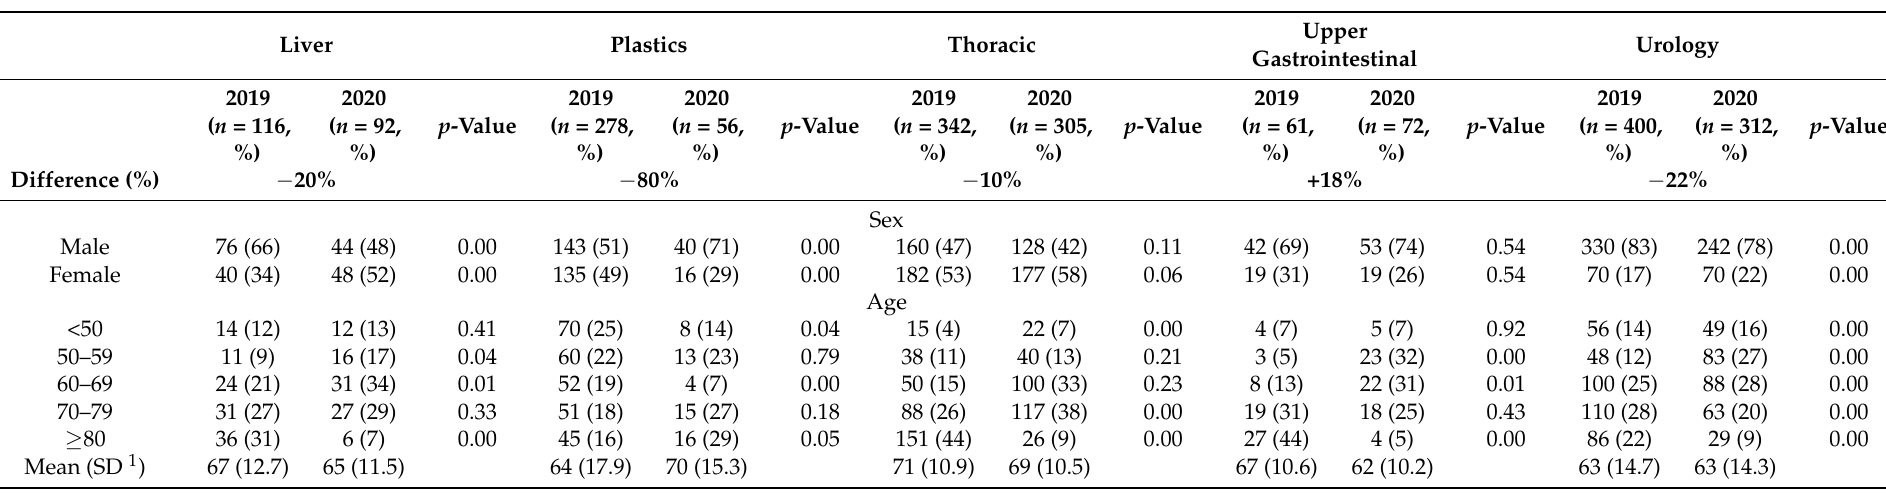
Table 5. FSELCA patient characteristics of cancer patients receiving radical surgery between 23 March 2019–8 September 2019 and 23 March 2020–8 September 2020, divided by cancer